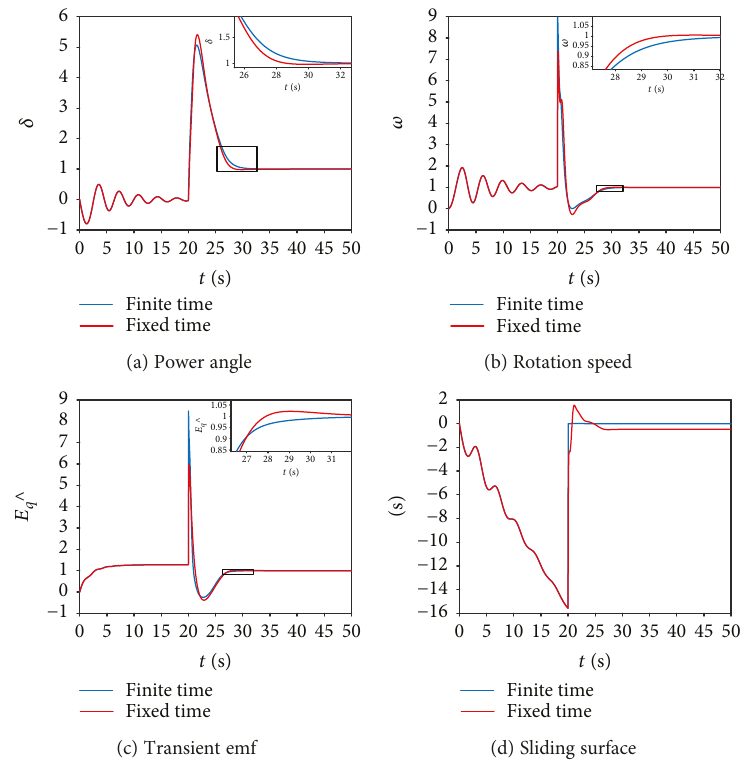
Figure 1: The comparison between fi xed-time sliding-mode controller and fi nite-time sliding-mode controller.